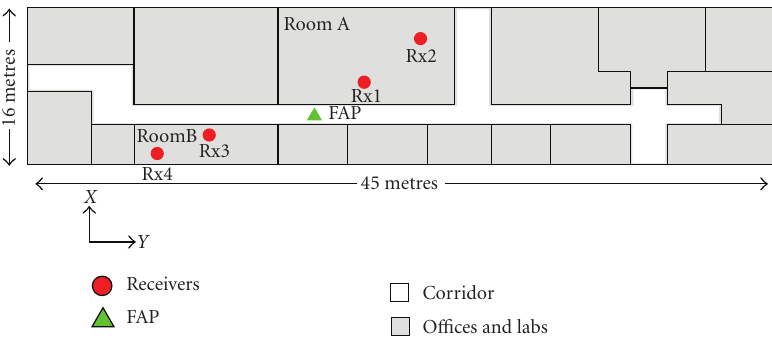
Figure 10: Floor plan of the second floor of Electronic Engineering Building at QMUL.